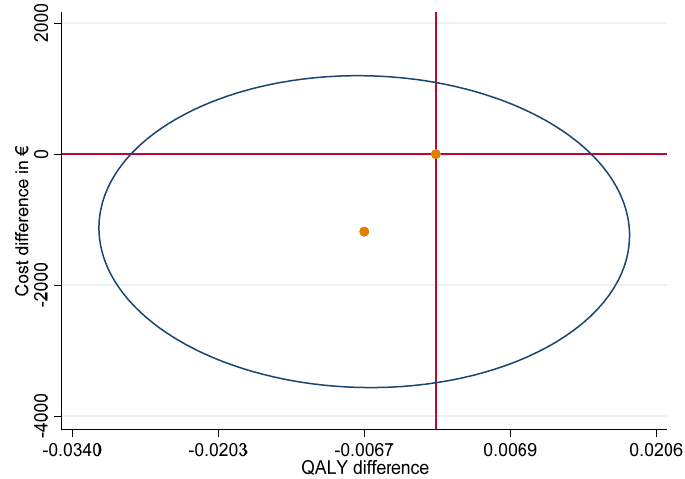
Figure 2. The location of the ICUR in the cost-effectiveness plane and the 95% variance ellipse (outer ellipse) of the ICUR